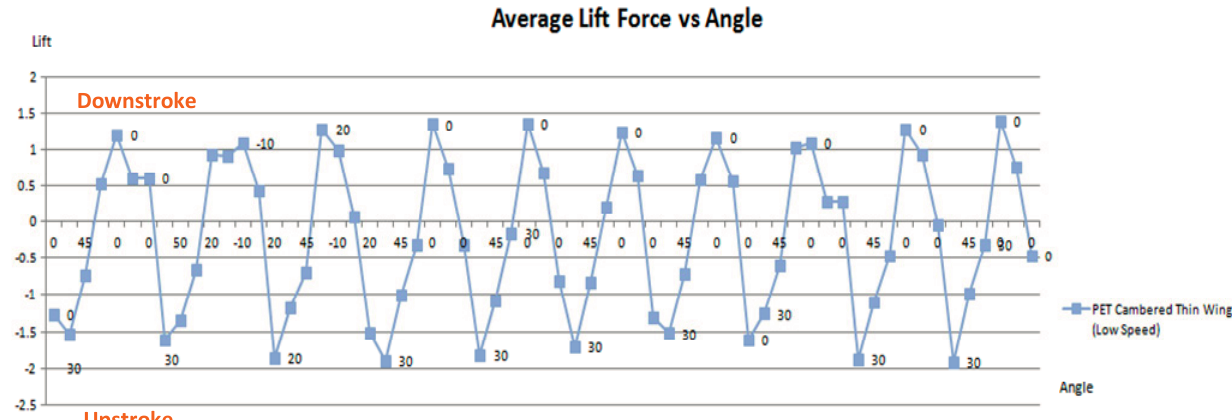
Figure 35. PET cambered thin wing lift against time (10 full cycles).